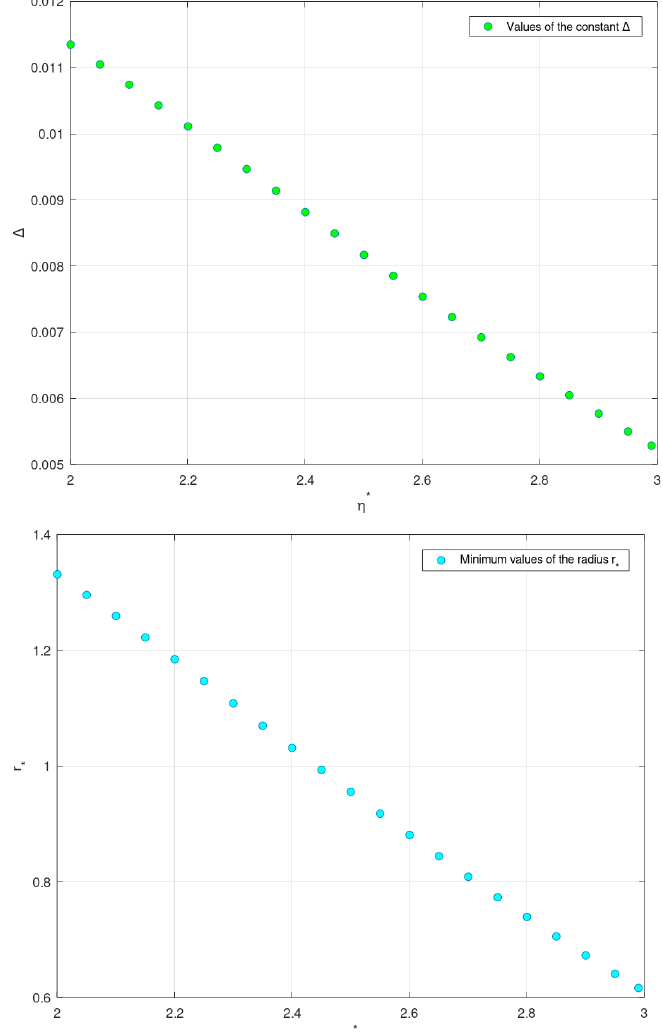
Figure 1. Values of ∆ and min r ∗ with respect to different values of η ∗